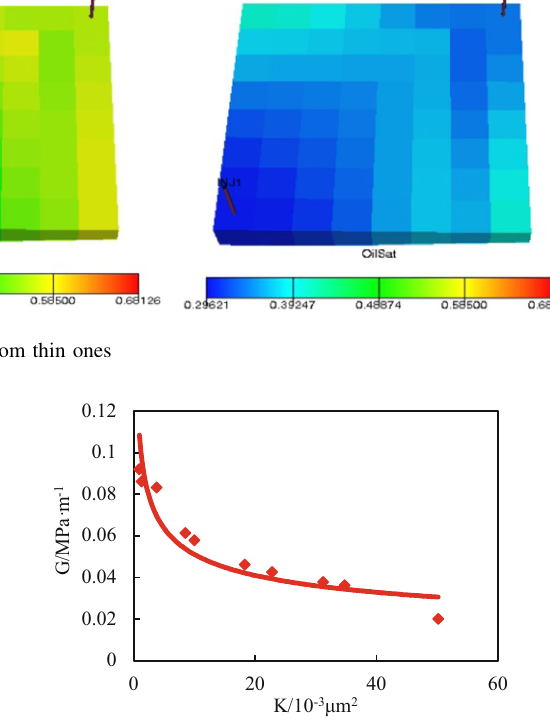
Fig. 9 Relationship between threshold pressure gradient and